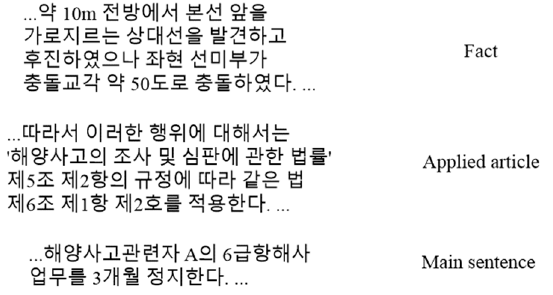
Figure 1. An example of facts, applied articles, and main sentence excerpted from the verdict.